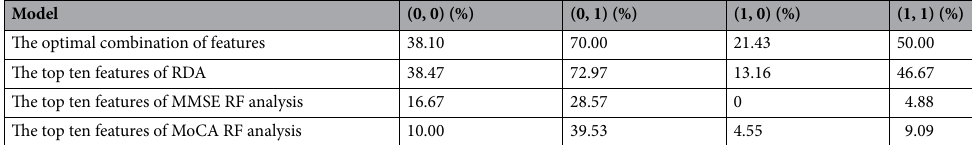
Table 9. Different candidate variables predict the correct probability at the same